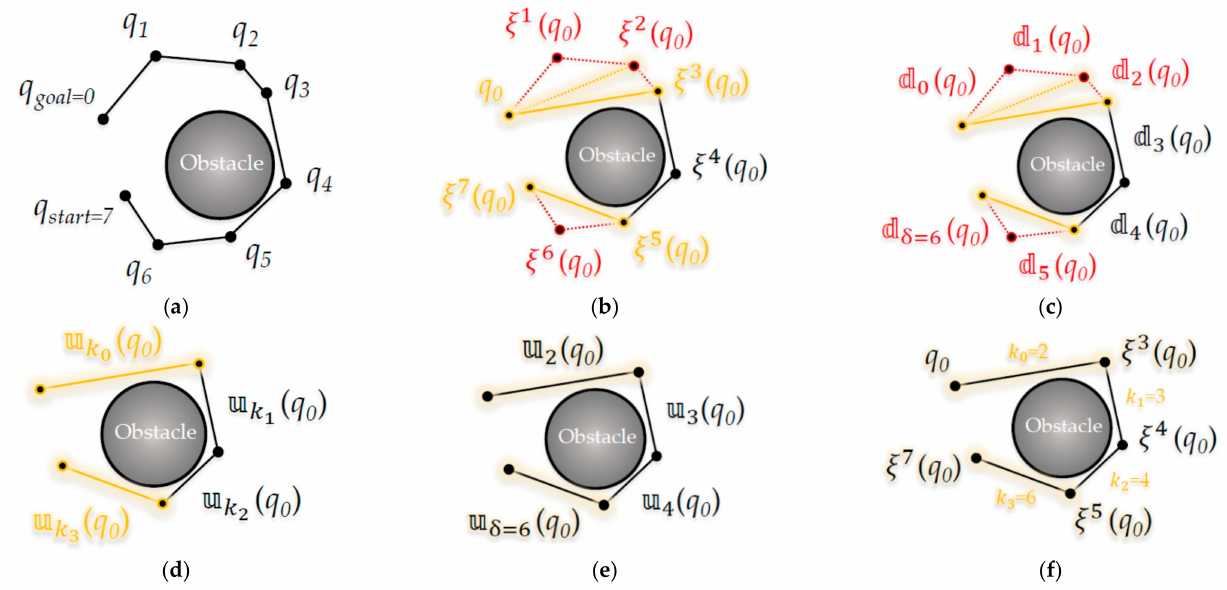
Figure 6. Detailed process of the ‘Triangular-Rewiring’ method: ( a ) Each node q for index i (at this time, q start is same as q 7 and q goal is same as q 0 ); ( b ) Represent each node using the n -th ancestor ξ n of q 0 ; ( c ) Each distance d n between the n -th and ( n + 1)-th ancestor nodes of q 0 ; ( d ) When the ‘Triangular-Rewiring’ method is applied and rewired by distance u k ( e ) Represent as the value of k j ; ( f ) Represent each node by the n -th ancestor ξ n of q 0 after method is applied.